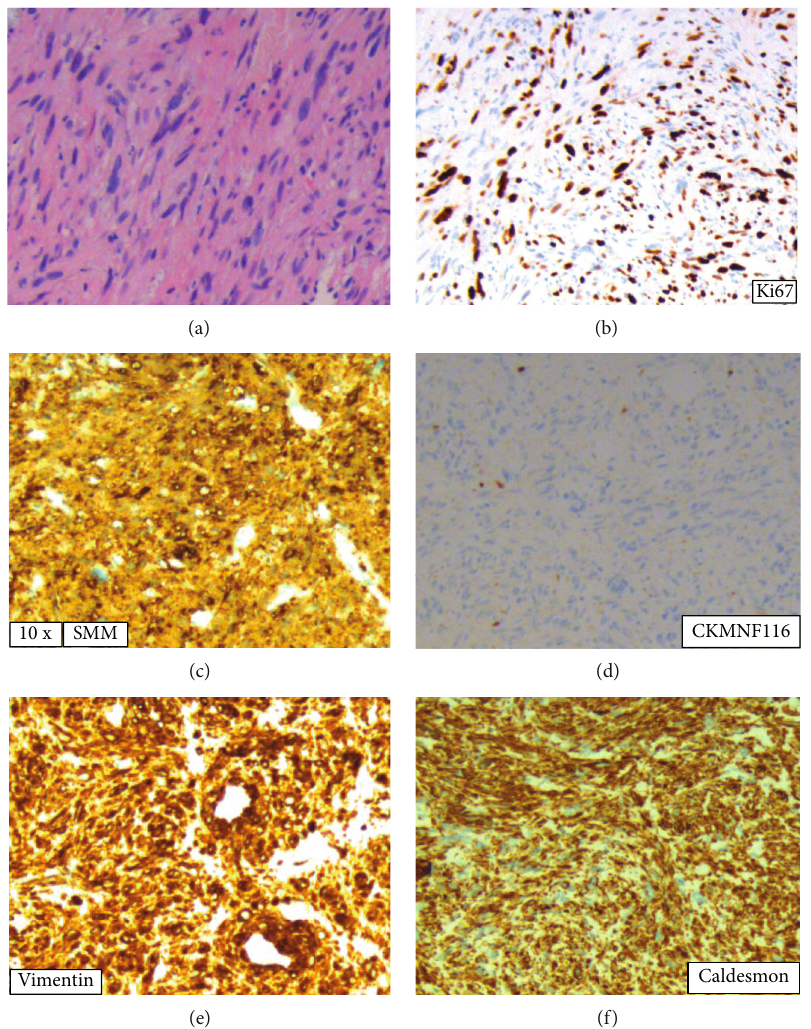
Figure 2: (a) Hematoxylin-eosine from the biopsy material shows solid nests of spindle cells containing fascicular growth pattern, tumor cell merge with blood vessel walls, palisading of spindle cells with eosinophilic fi brillary cytoplasm, focal granularity, and large nuclei cigar-shaped blunt-ended with variable atypia. (b) High mitotic activity is seen with Ki67. (c – f) Tumor cells were positive for smooth muscle actin, caldesmon, and vimentin indicating a nonbreast tissue origin rather than indicating a smooth muscle origin. (d) Tumor cells were negative for